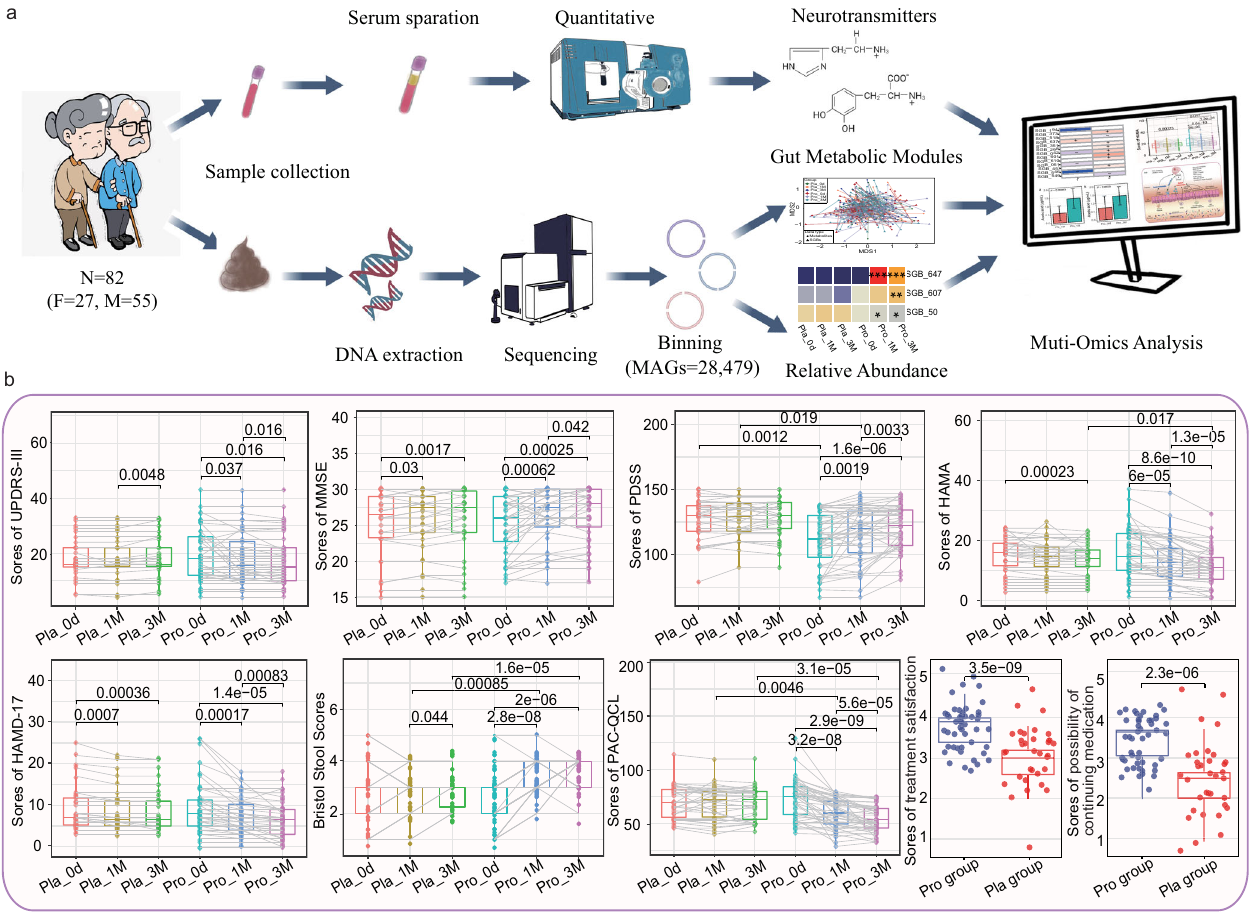
Fig. 1 Experimental design, data analysis, and clinical indexes of Parkinson ’ s disease. a The work fl ow of sampling, sequencing and metagenome-assembled genomes (MAGs) binning of gut microbiota and serum neurotransmitters, all elements in this image were the graph of results of this article or created by in iPad. b Statistical differences in the clinical parameters within and between groups were evaluated with paired t -tests and t -tests, respectively. Signi fi cant p values between sample pairs are shown. Boxplot elements: center line, median; box limits, upper and lower quartiles; whiskers, 1.5x interquartile range; points, outliers. Each dot represents a data point of a participant, and data of the same participant at different time points are connected by straight lines. “ Pro ” and “ Pla ” represent the Probio-M8 group and Placebo group, respectively. “ 0d ” , “ 1 M ” , and “ 3 M ” represent the baseline before the intervention, 1 and 3 months after intervention, respectively. UPDRS-III, MMSE, PDSS, HAMA, HAMD-17, PAC-QOL represent Uni fi ed PD Rating Scale-III, Mini-mental State Examination, Parkinson ’ s Disease Sleep Scale, Hamilton Anxiety Scale, Hamilton Depression Scale-17, Patient-Assessment of Constipation Quality of Life, Meanwhile, the PCoA (Bray-Curtis distance) score plot did not show any time-based clustering patterns ( P > 0.05, Fig. 2b). These results suggested that the drug treatment with or without probiotic supplementation did not cause drastic changes in subjects ’ gut microbiota diversity and structure. In addition, no